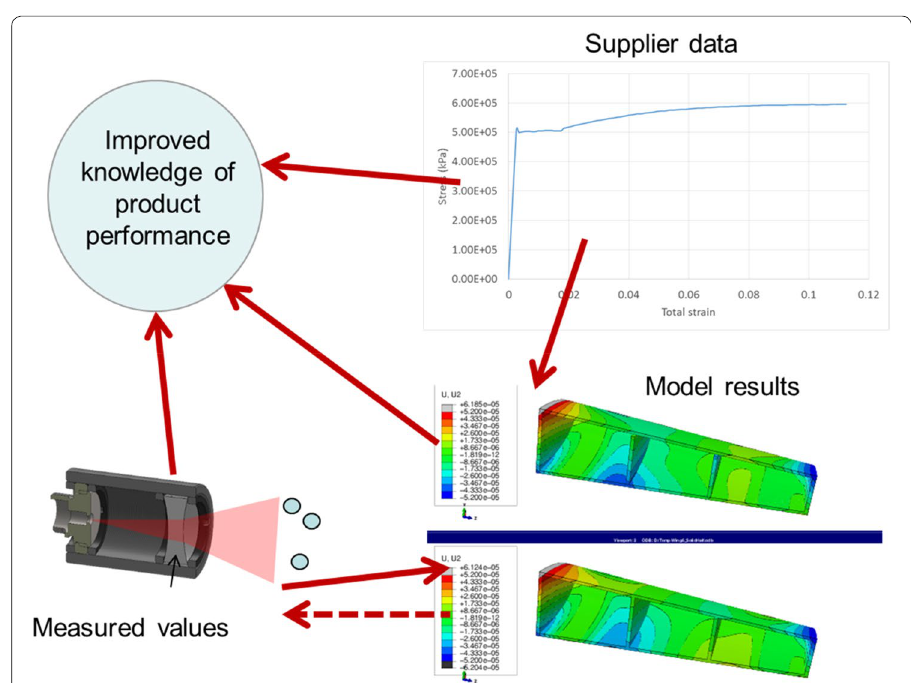
Fig. 2 Sketch of a potential digital twin information